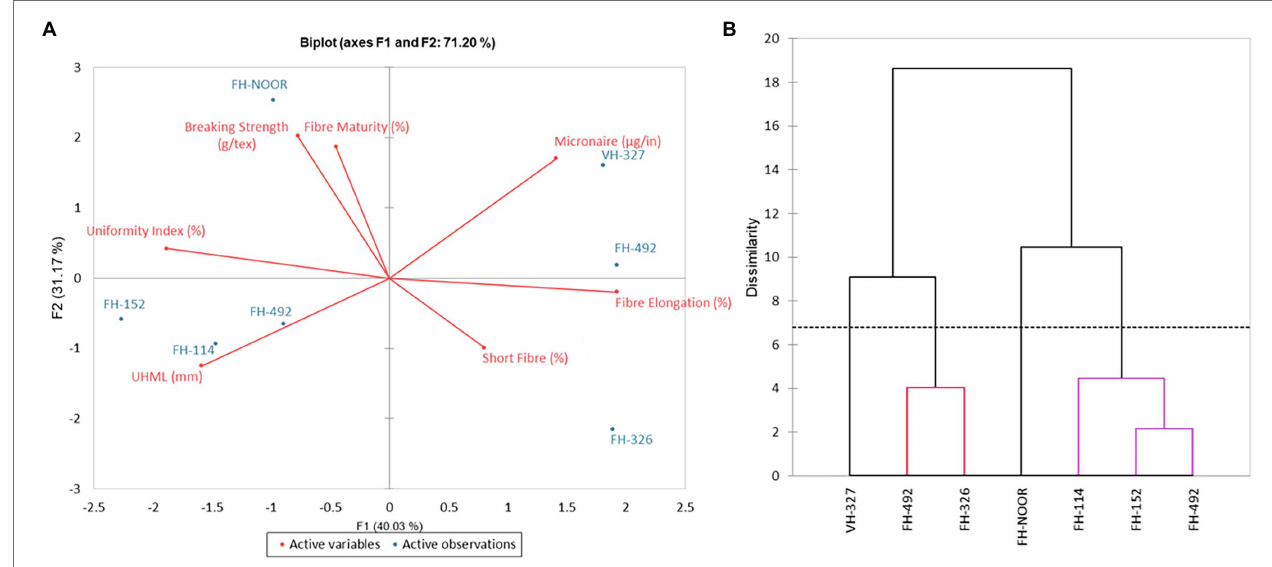
FIGURE 6 | Principal component analysis (A) and dendrogram (B) of fibre quality parameters of cultivated varieties of Gossypium hirsutum